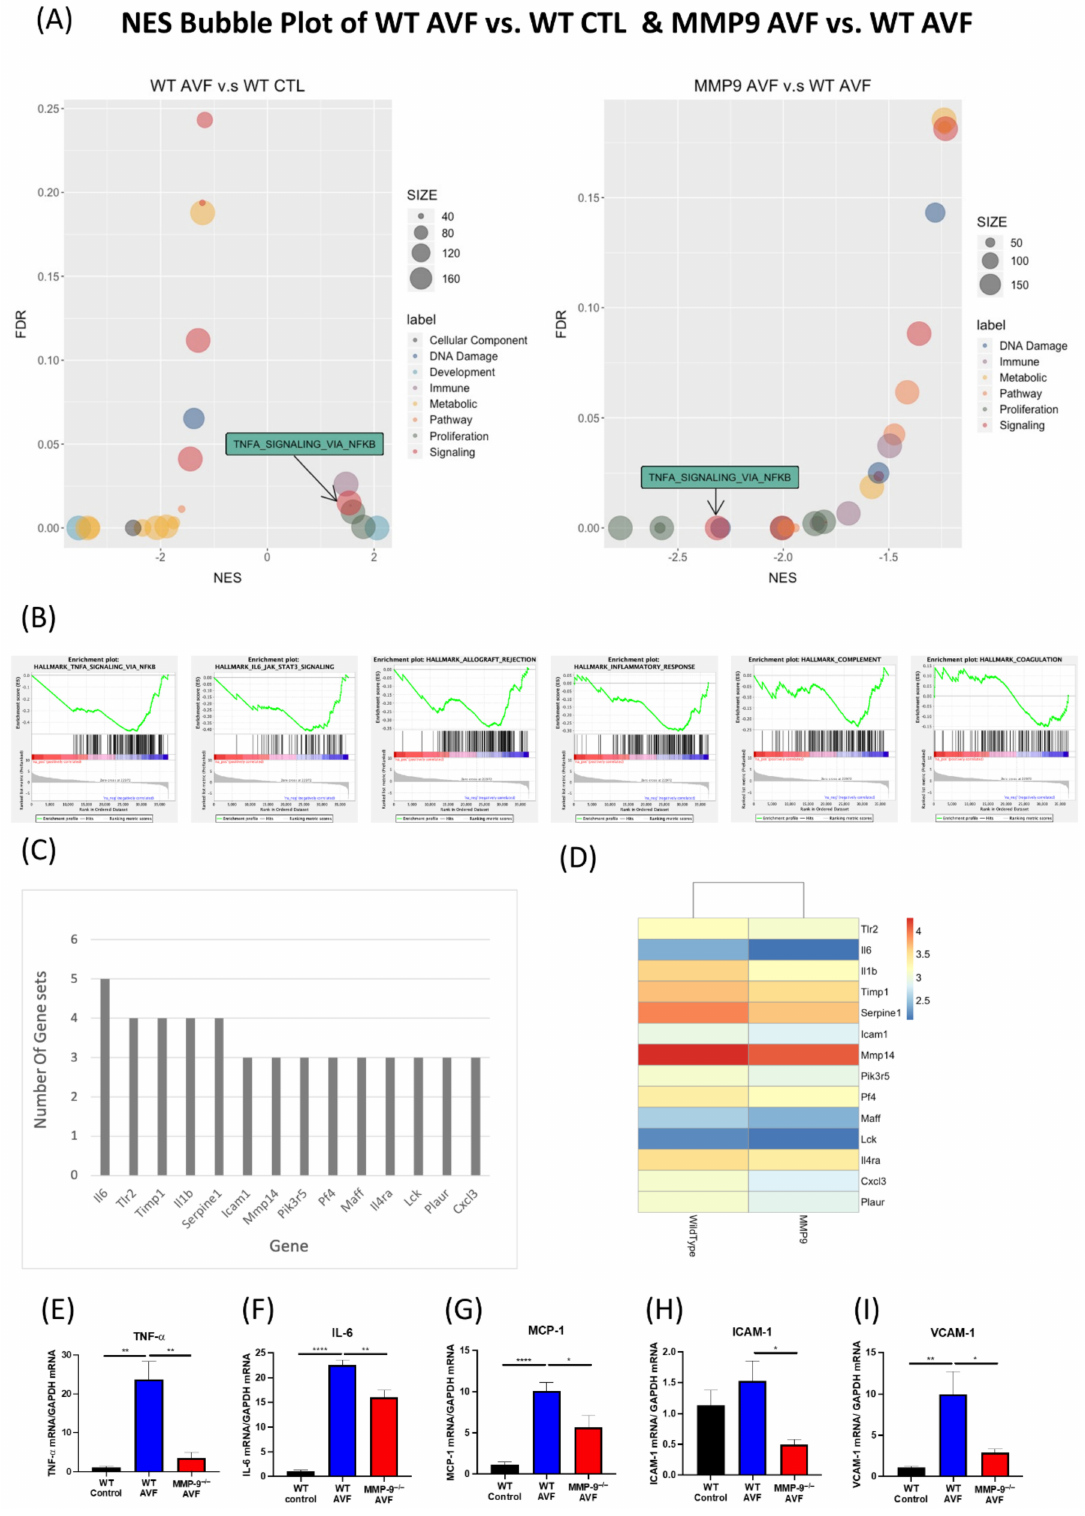
Figure 5. Genome-wide mRNA expression difference of WT and MMP-9 − / − mice AV fistulas. ( A ) Gene set enrichment analysis (GSEA) with Hallmark gene sets was performed to analyze the differentially expressed genes between WT and MMP-9 − / − mice. Significantly enriched pathways in different categories are visualized using bubble plots of normalized enrichment score (NES) for different comparisons, including WT AVF vs. WT CTL and MMP9 AVF vs. WT AVF, and the size of each bubble is proportional to the number of core genes within the pathway. Only pathways with FDR < 0.25